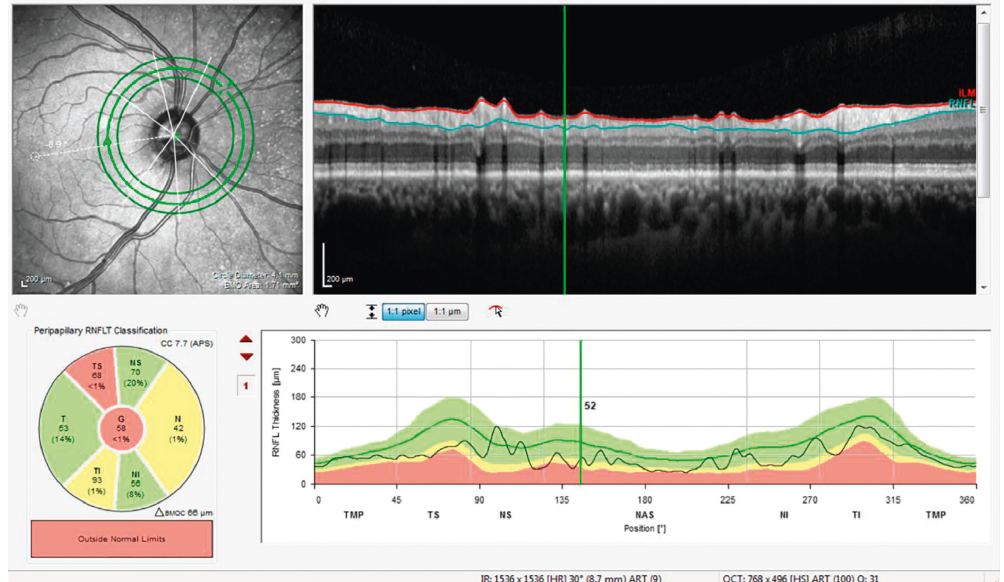
Figure 4: Circumpapillary retinal nerve fiber layer thickness